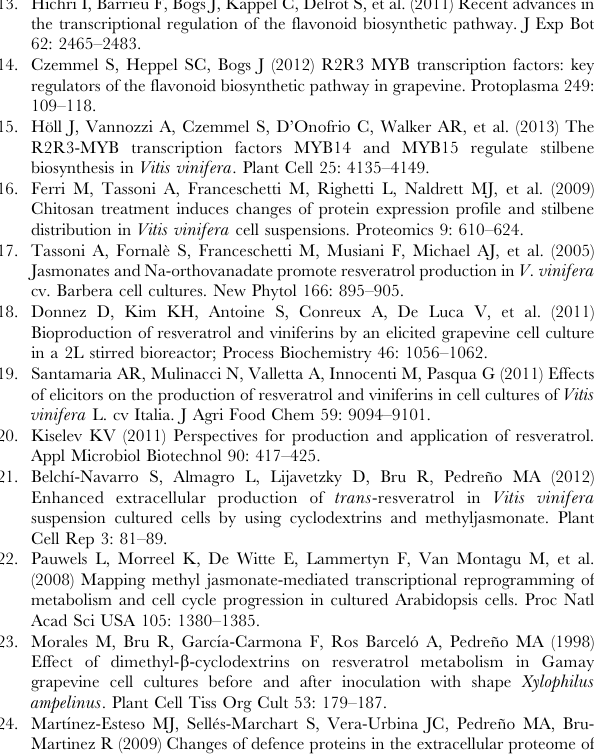
Figure S1 qRT-PCR expression validation of the micro- array hybridization experiments. Figure S2 Treatments significantly regulated gene ex- pression profiling summary. Figure S3 Mapman visualization of the significant genes in the ‘Amino acid metabolism’ pathway.